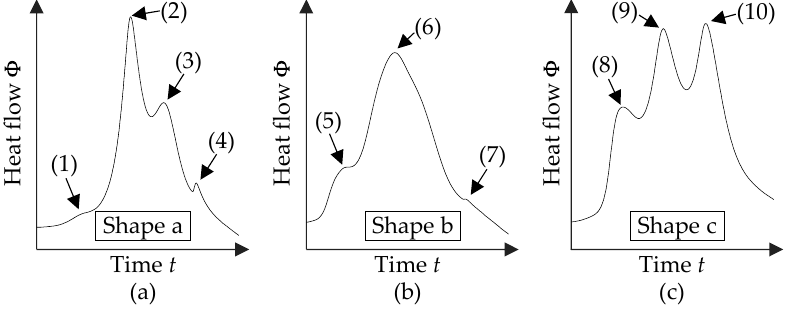
Figure 5. Typical measurement curves for t 2 < t < t 4 : ( a ) experiment no. 58; ( b ) experiment no. 30; ( c ) experiment no. 47.